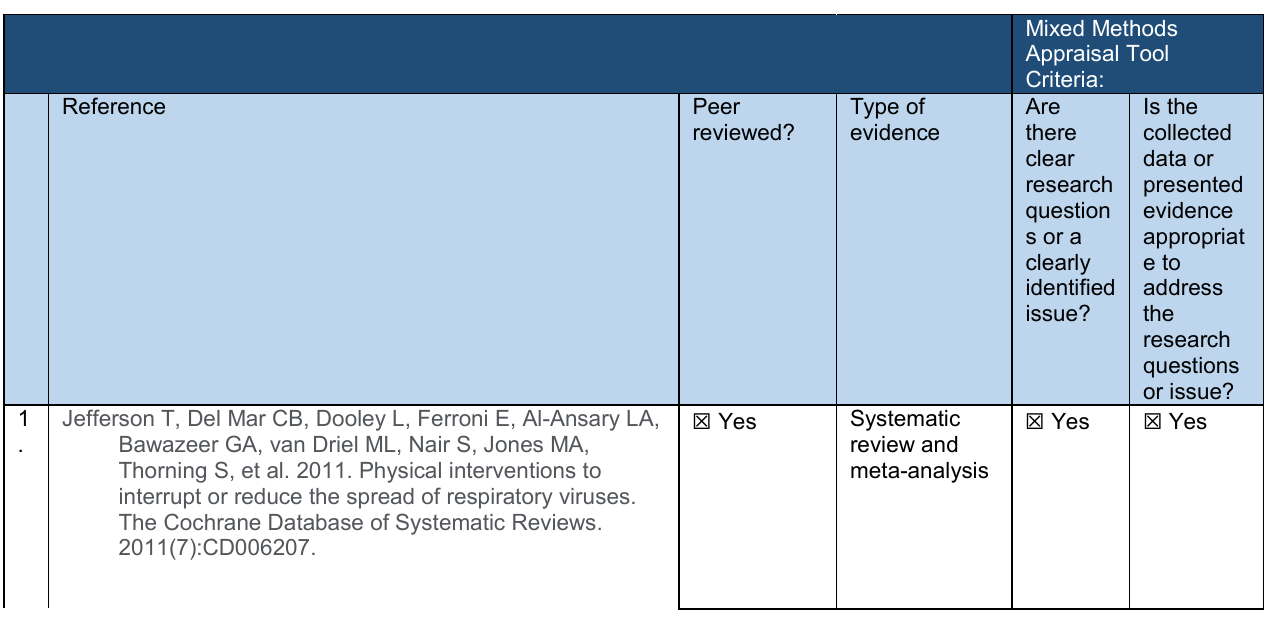
Table 2. Summary of quality assessment results for articles included in this